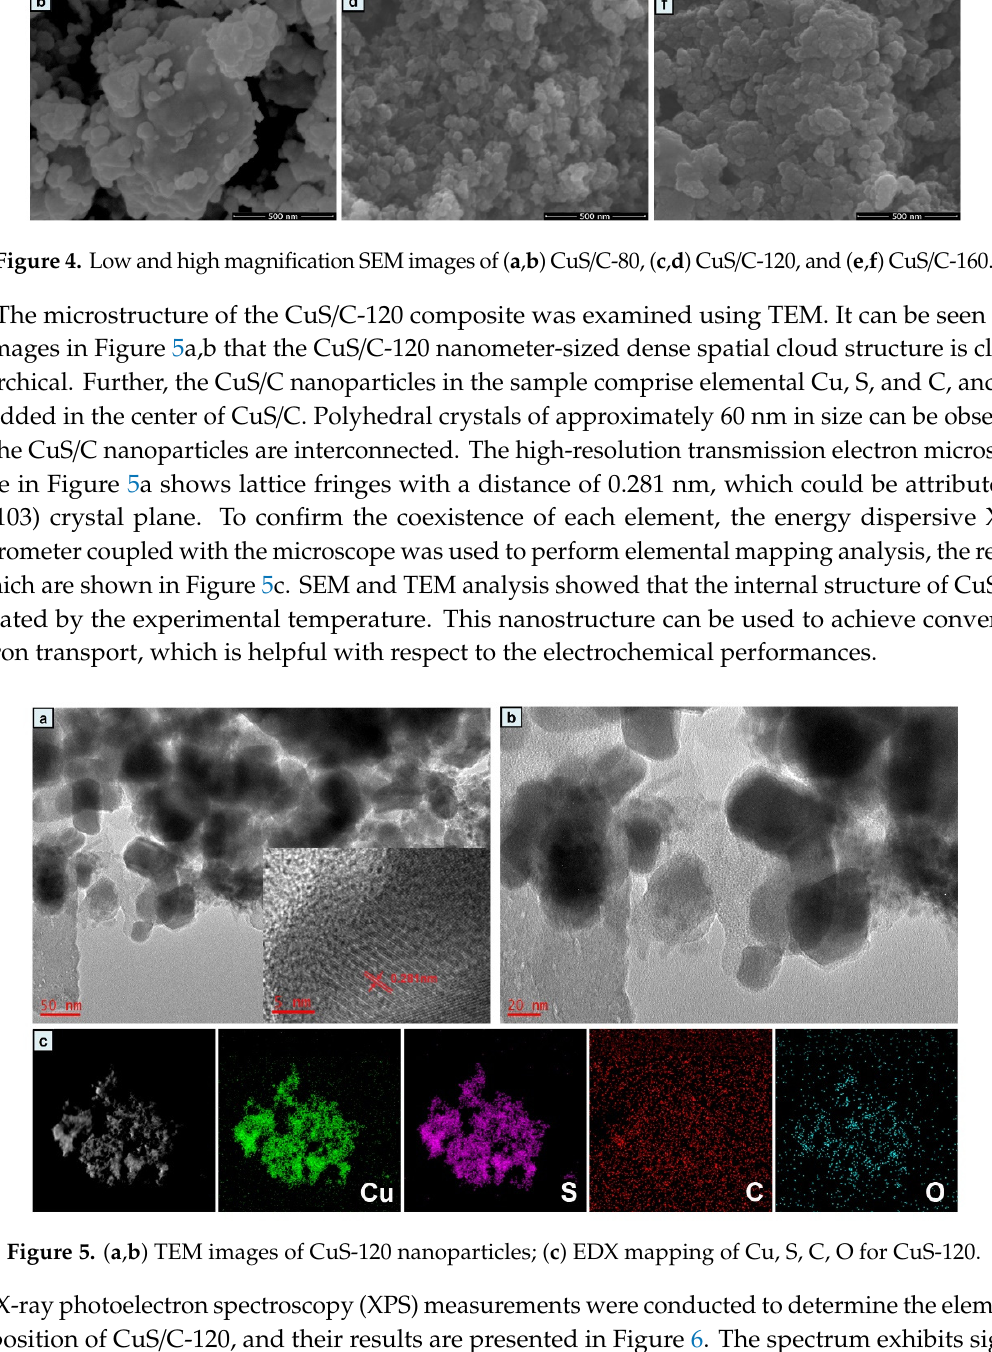
Figure 5. ( a , b ) TEM images of CuS ‐ 120 nanoparticles; ( c ) EDX mapping of Cu, S, C, O for CuS ‐ 120.